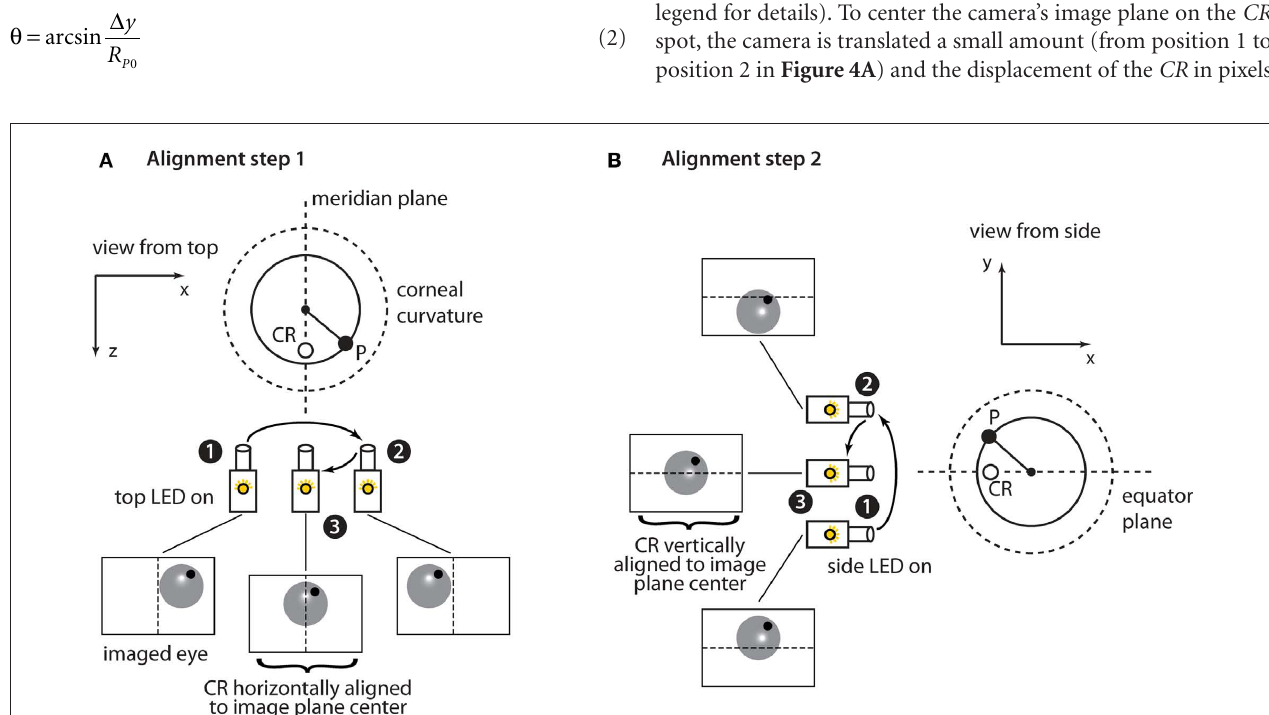
Figure 4 | Horizontal and vertical alignment of the eye with the center of the camera’s sensor. (A) When the horizontally aligned (top) infrared LED is turned on a corneal reflection ( CR ) spot (empty circle) appears halfway along the radius of the corneal curvature (dashed line) that is parallel to the optic axis of the camera. The filled circle shows the pupil position. The large dashed circle shows the corneal curvature/surface. Assuming that the camera’s sensor is initially not aligned with the center of the eye (e.g., in position 1), the location of CR can be used as a landmark of the eye’s meridian plane to achieve such an alignment by moving the camera’s assembly horizontally. The camera is first translated a few mm (from position 1 to position 2) to determine the mm/pixels